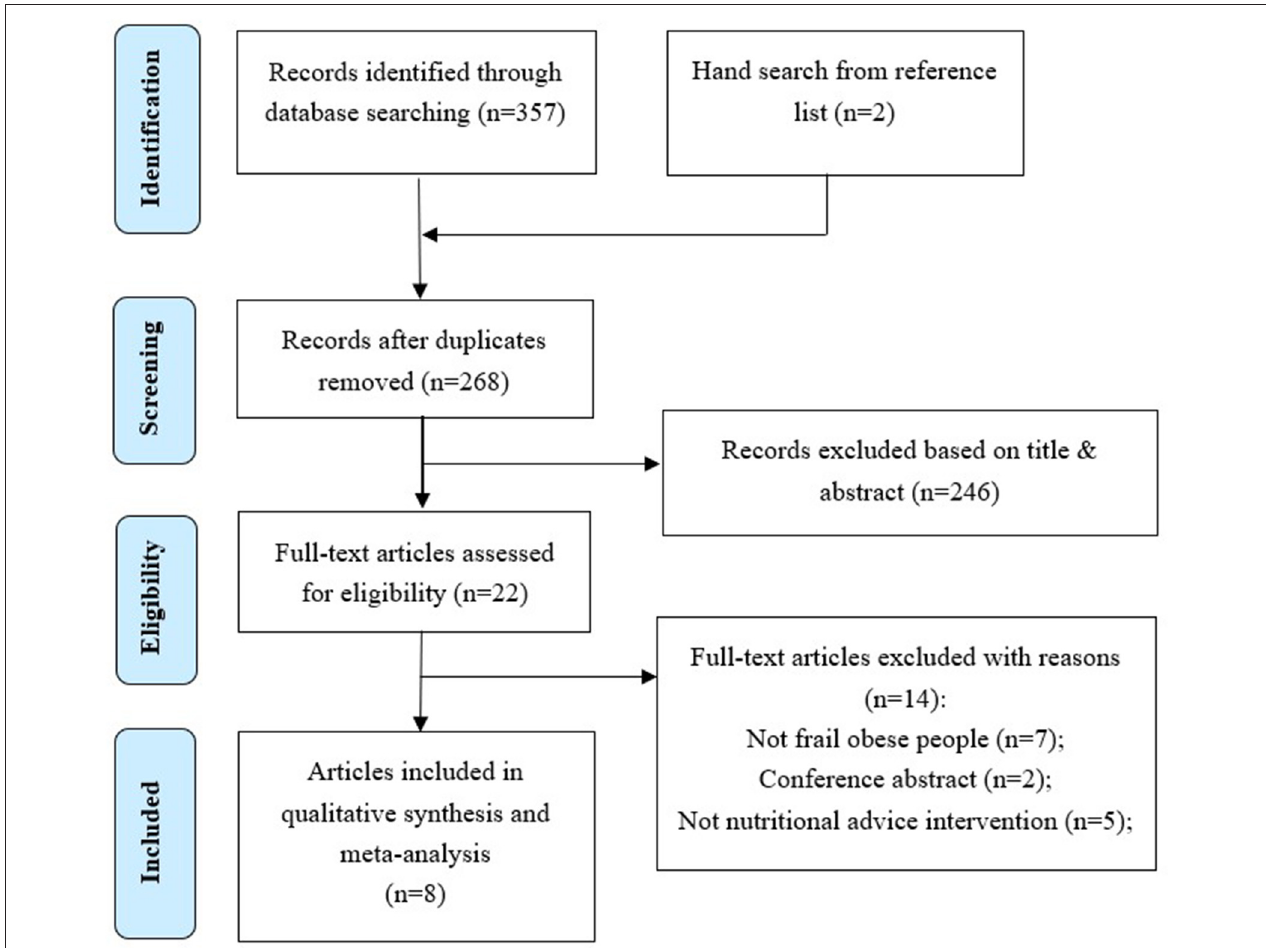
FIGURE 1 | Flow chart of the study selection